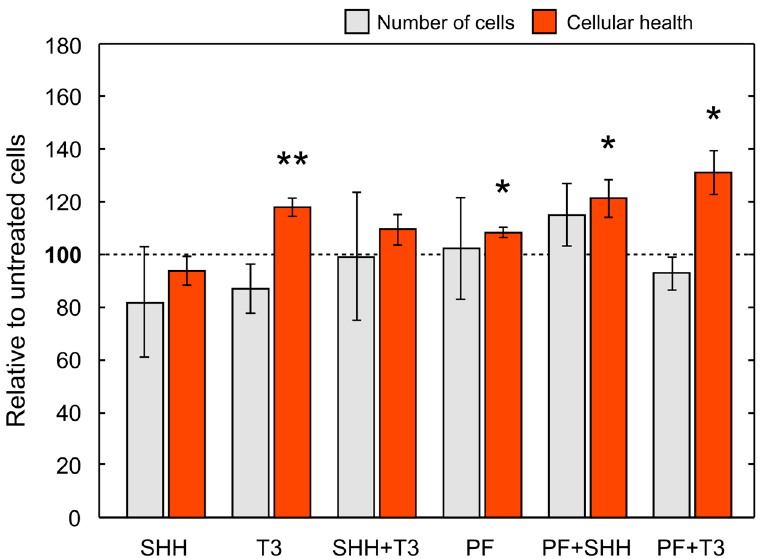
Figure 5. Mean cell number and cellular health. Cell number and cellular health as determined by the MTS test on the last day (day 5) of the differentiation phase of the experiment (i.e., DIV 18) relative to control cells. The error bars represent ± SEM. Statistically significant difference relative to control cells: * p < 0.05, ** p < 0.01.